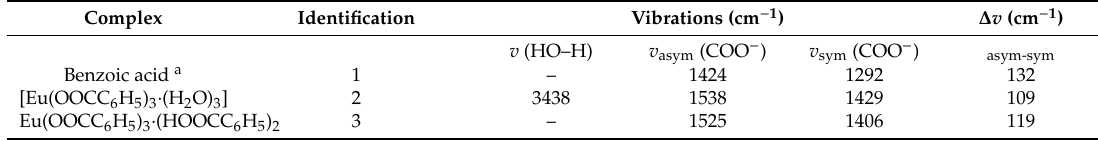
Table 1. Overview of synthesis